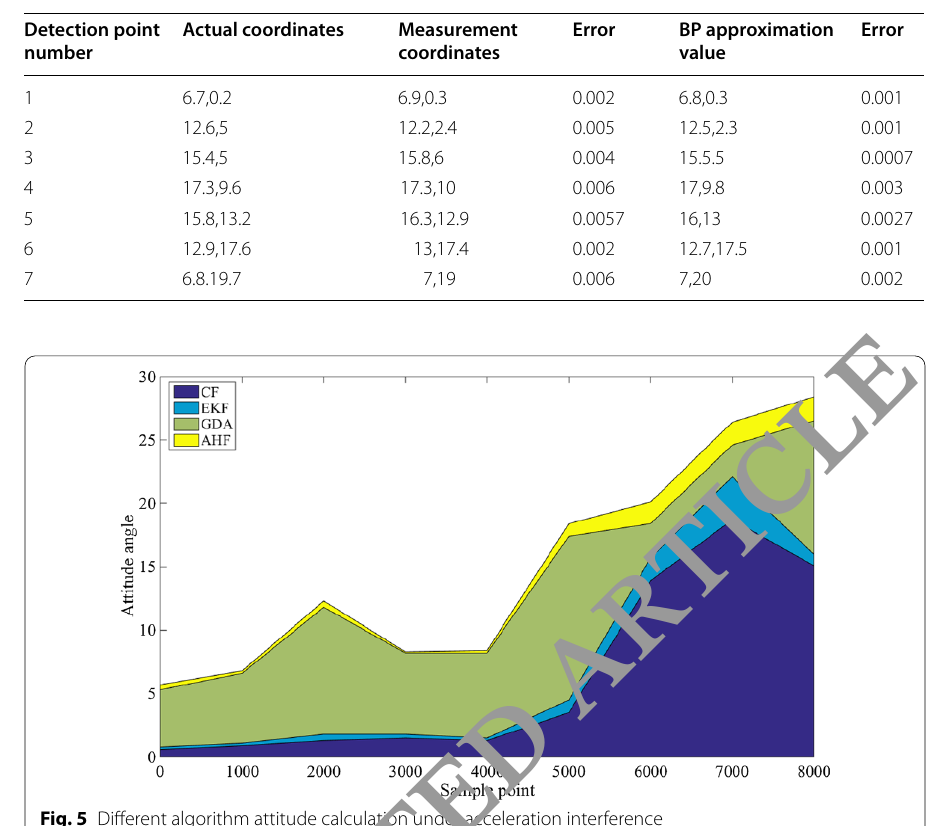
Table 1 Test results and errors